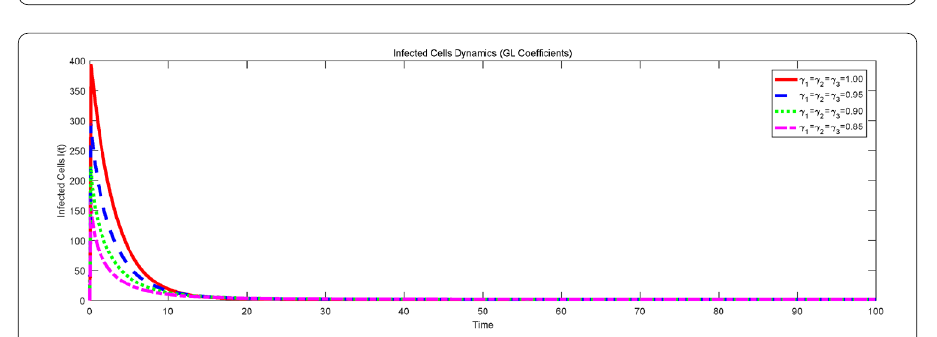
Figure 11 Dynamics of S ( t ) with γ i = 1 (solid red line), γ i = 0.95 (dashed blue line), γ i = 0.9 (dotted green line) and γ i = 0.85 (dotted dashed magenta line), i = 1,2,3.